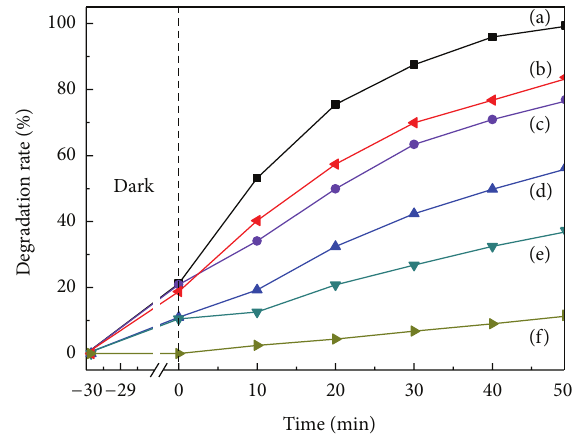
Figure 6: Effects of calcined temperature of 1.5-Na 2 Ti 6 O 13 /TiO 2 : (a) 600 ∘ C(b)500 ∘ C;(c)commercialP25;(d)700 ∘ C;(e)800 ∘ C;(f)blank.